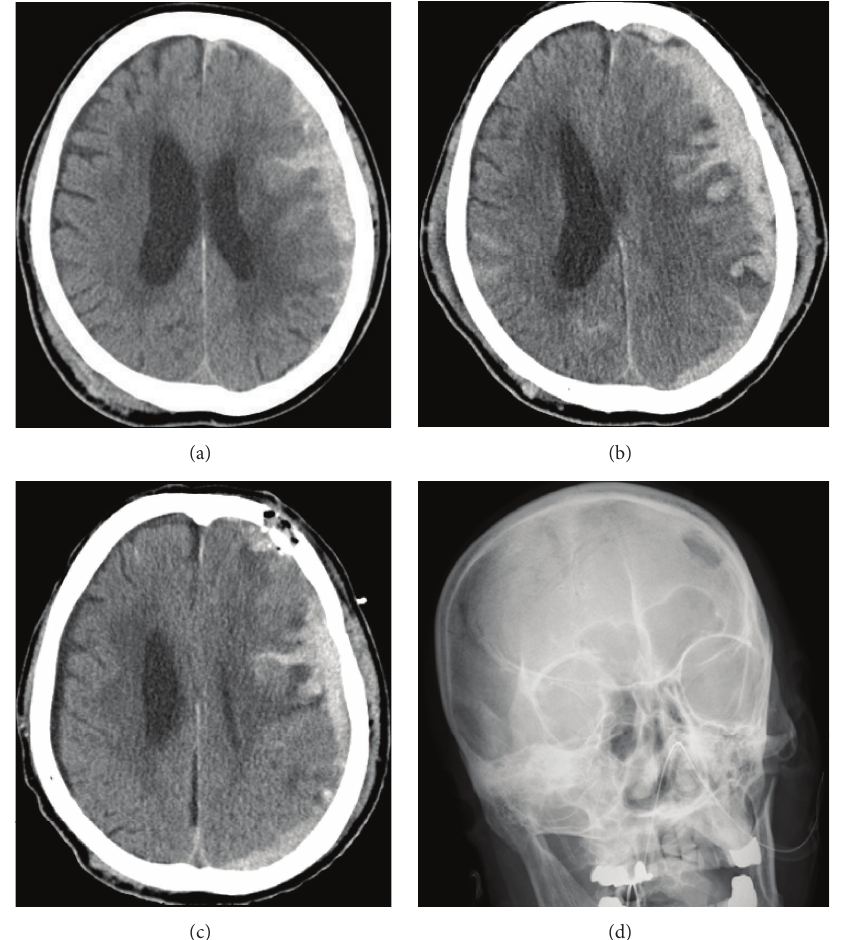
Figure 1: (a) Axial plain CT scan at the time of admission shows left acute subdural hematoma and bilateral frontal contusion with thickness of 14mm and midline shift of 8 mm. There is a bruised area in the right parietal region without bone fracture. (b) Axial plain CT scan 72 hours after admission shows worsened acute subdural hematoma with thickness of 16mm and midline shift of 9 mm. Massive contusion of the left frontal lobe has occurred. (c) Radiographic frontal view shows the location of the burr hole 4 cm above the left eyebrow. (d) Axial plain CT scan after surgery shows reduced hematoma. Midline shift had improved to 4 mm. There is a small amount of air in the subdural space. Burr hole is covered by bone